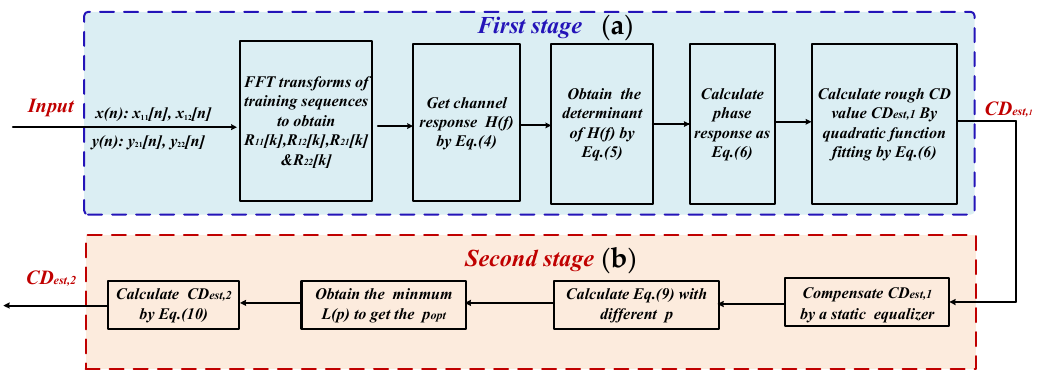
Figure 2. Block diagram of the proposed CDE scheme consisting of two stages: ( a ) the first coarse stage using TSs, and ( b ) the second fine stage using optimized FrFT.